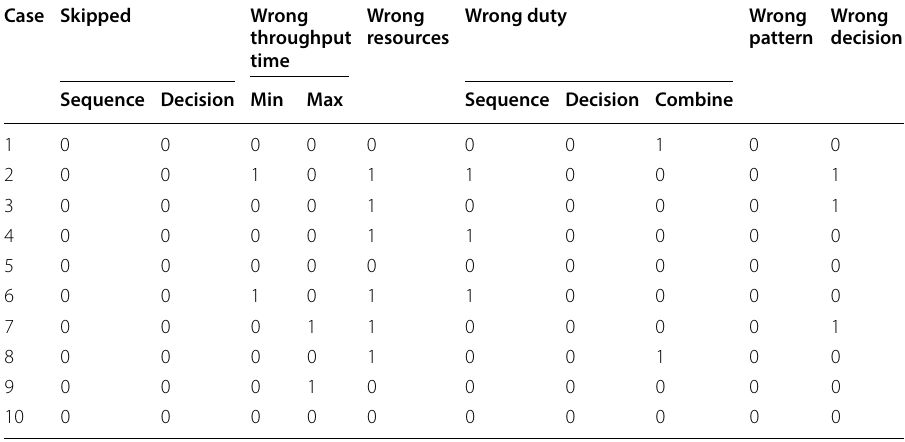
Table 12 The distribution of anomaly attributes among cases using a uniform (discrete) distribution